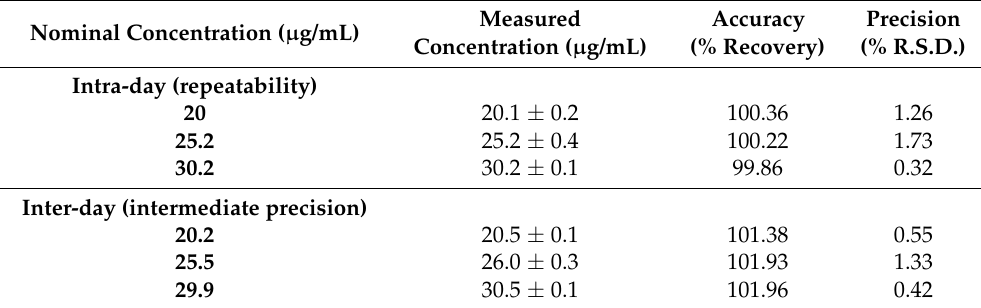
Table 3. Validation parameters of HPLC method for determination of OxyCl.